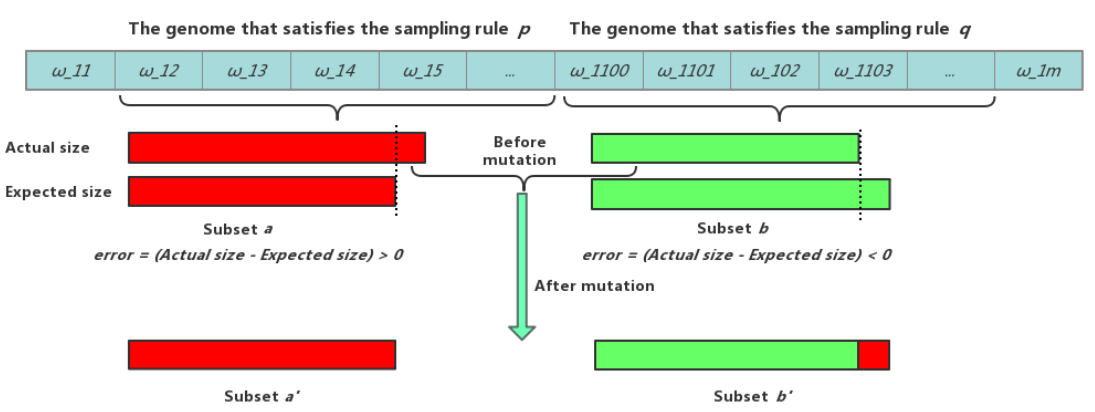
Figure 4. Schematic diagram of the improved mutation